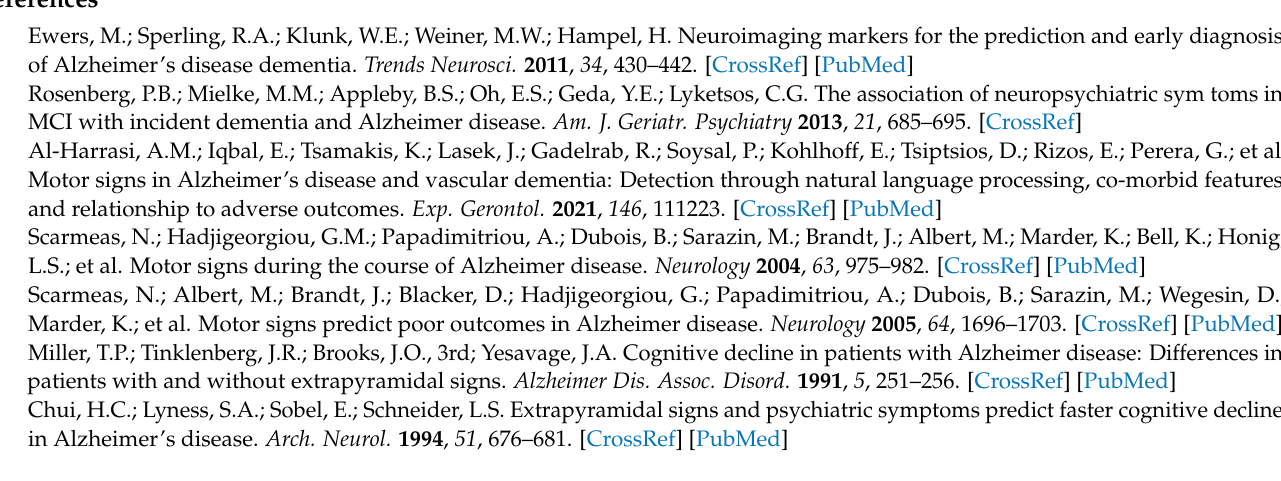
Tables S1–S3: (Table S1: Number of the subjects per 9 created motor signs and cognitive domains; Table S2: The number of the subjects per 9 created motor signs and cognitive domains, after excluding subjects with cerebrovascular disease or Parkinson’s disease or other Parkinsonian disorder; Table S3: Sensitivity analysis with linear regression, for association between motor signs (that significantly associated in the main analyses) and performance in cognitive domains, after excluding subjects with cerebrovascular disease or Parkinson’s disease or other Parkinsonian